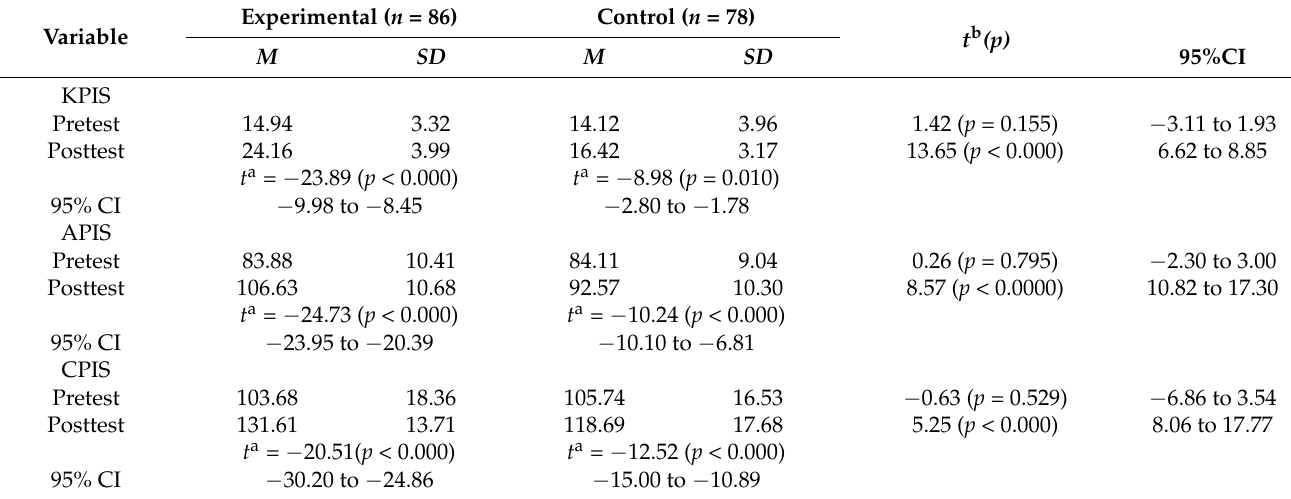
Table 3. Comparison of knowledge, attitudes, and confidence scores between the two